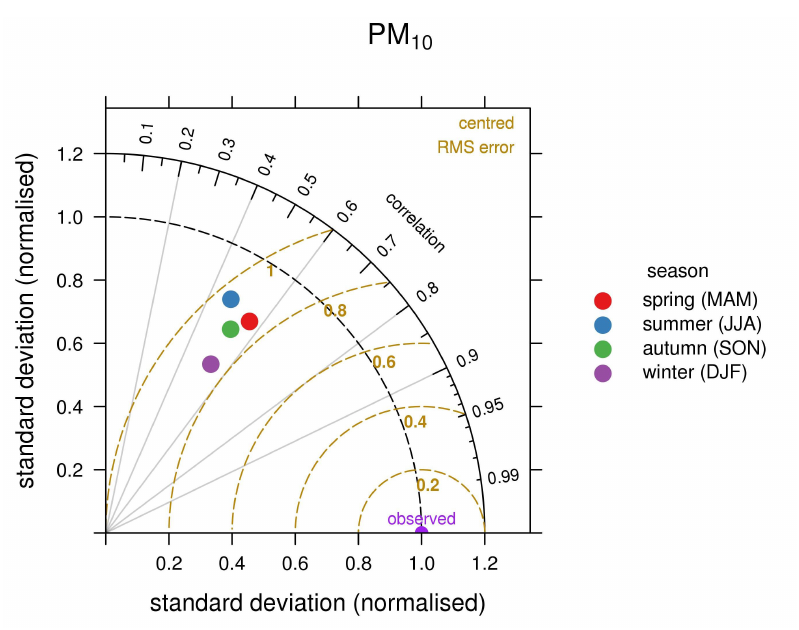
Figure 10. As in Figure 8, but for PM 2.5 .